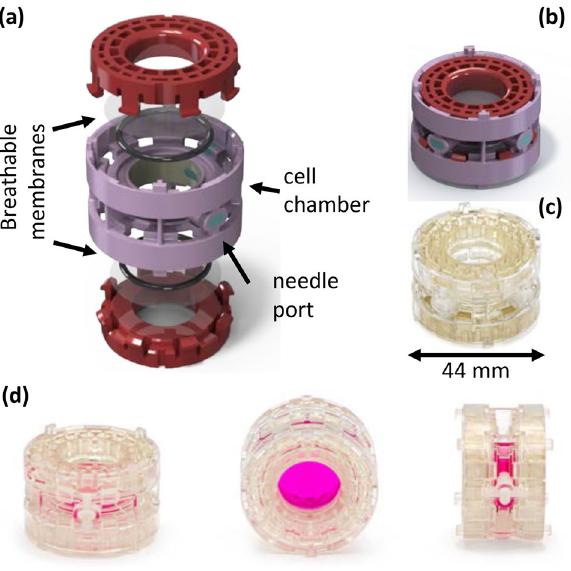
Figure 1. Components of the cell spinpod. Components of the cell spinpod. Panels ( a ) and ( b ) are CAD renderings prepared by author AR, with SolidWorks 2020 Professional Service Pack 4 (https:// www. solid works. com/ lp/ just- cad). The cell/media chamber, in lilac, is sandwiched between two breathable membranes that are sealed on two sides with silicone rubber O-rings and held in place with retaining caps (shown in red) with eight snap features on each. There are two surface-bonded self-sealing silicone rubber needle ports (shown in turquoise) incorporated through the side walls of the cell chamber, for loading cells/media and for bleeding the air during loading. Panel ( c ) shows an actual empty cell spinpod and Panel ( d ) shows three views of a cell spinpod filled with pink media. Photographs in panels ( c ) and ( d ) were taken by author HB.